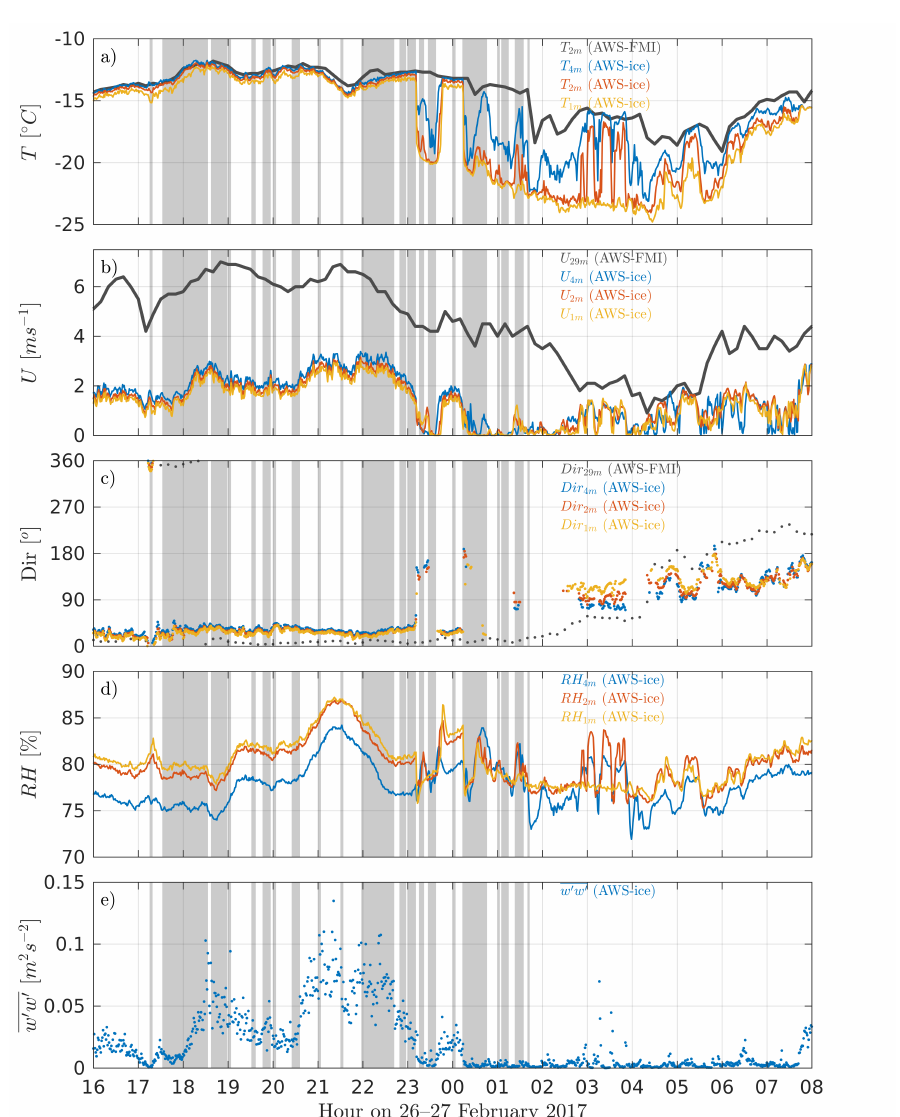
Figure 11. Time series of temperature, wind speed, wind direction, relative humidity, and vertical velocity variance (from top to bottom) during the night of 26 to 27 February. The displayed data represents 10-min and 1-min averaged data of ( a ) T ; ( b ) U ; ( c ) Dir ; ( d ) q ; and ( e ) w (cid:48) 2 from the permanent AWS-FMI on land and the three levels and EC of the AWS-ice, respectively. Gray shading indicates times of UAV